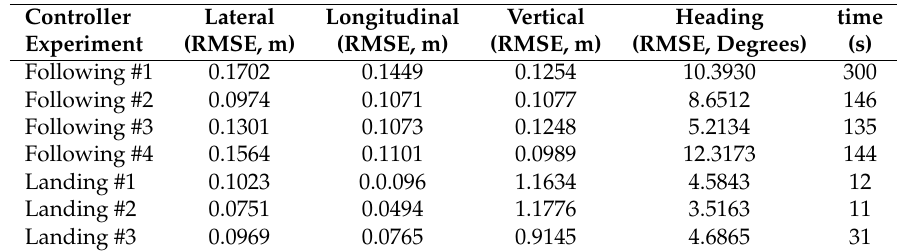
Table 2. Root mean square error for the lateral, longitudinal, vertical and heading velocity controllers for the autonomous following and landing on a moving